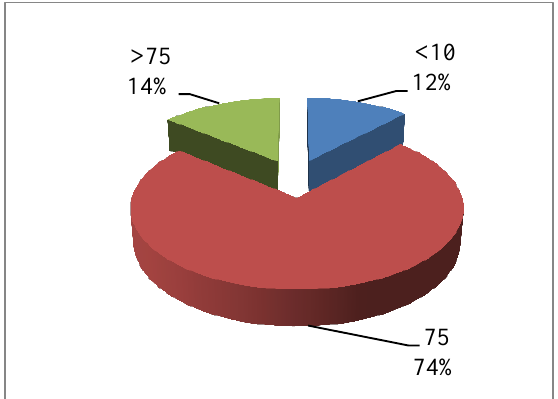
Fig. 3. Characterization of proteins by molecular weight of C. albicans fungi cells obtained with grinding